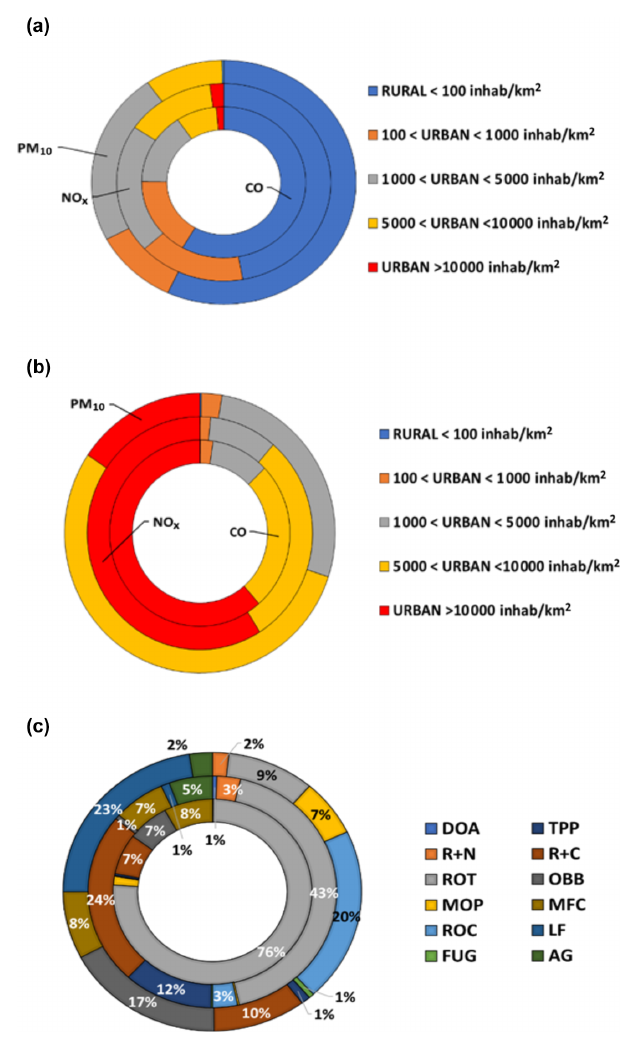
Figure 6. Annual PM 10 (outer ring), NO x (middle ring), and CO (inner ring) emissions distribution according to different classi- fications: (a) total emissions with respect to population density, (b) emissions density (kgkm − 2 yr − 1 ) with respect to urban den- sity, (c) total sectoral contribution (see Table 4). Reference codes are provided in Table